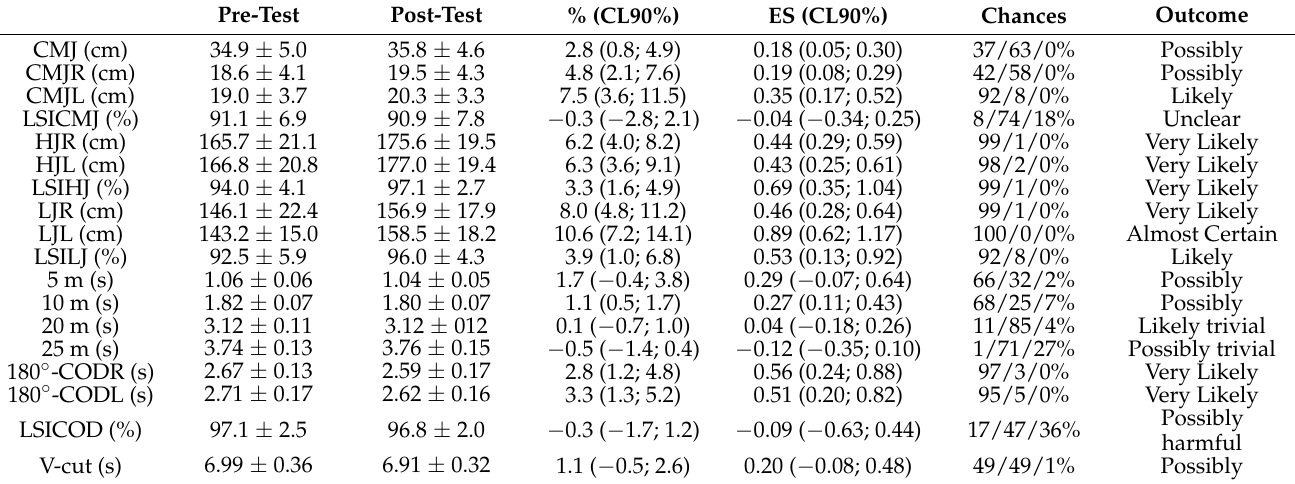
Table 3. Changes in performance after variable unilateral lateral (VUL, n = 11) eccentric overload